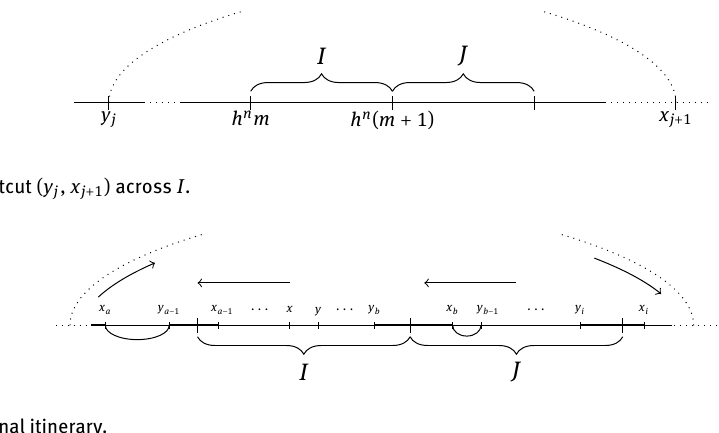
Figure 3: The original itinerary.